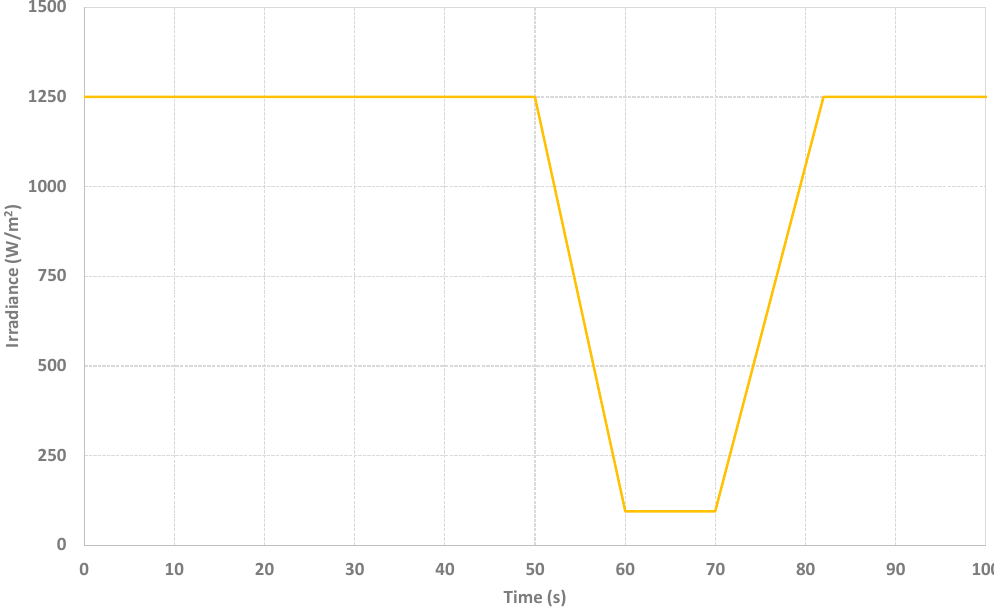
Figure 6. Irradiance profile applied to solar PV generation to simulate a cloud transient phenomenon.